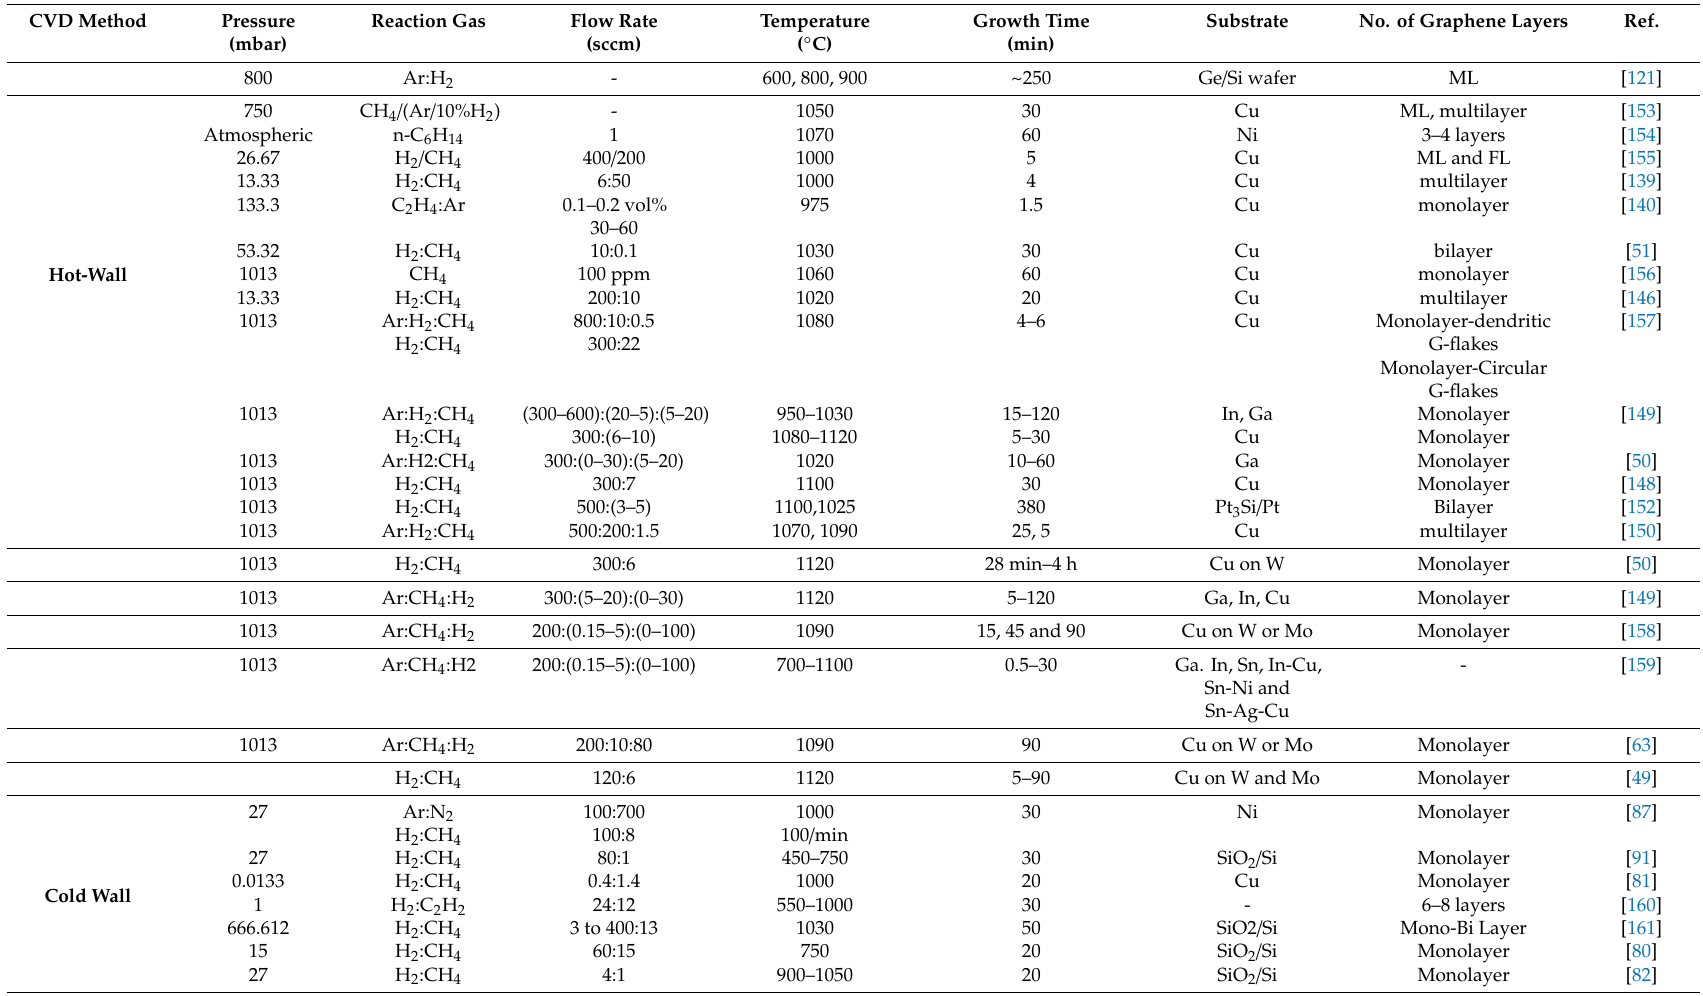
Table 1. Summary of reported literature of graphene growth conditions using di ff erent types of CVD